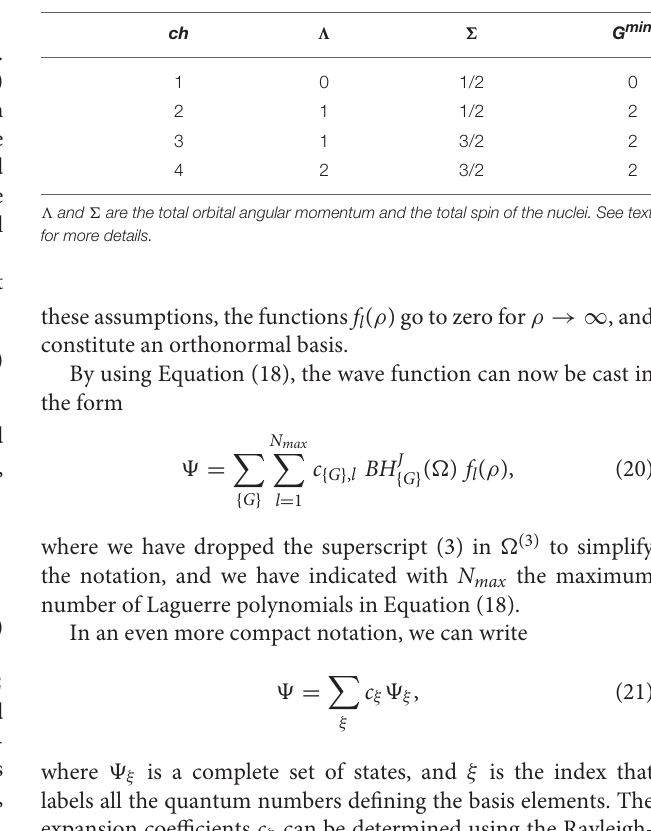
TABLE 1 | List of the channels for a J π